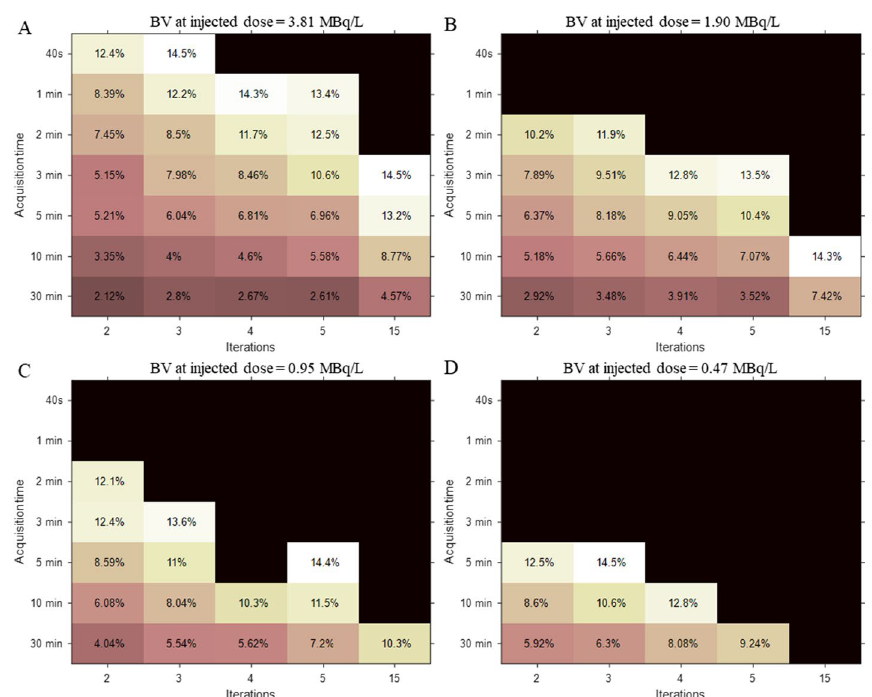
Fig. 2 Background variability (BV) map, which is derived from NEMA IQ phantom measurement (hot sphere: background, 4:1) at four estimated doses, as a function of both factors—acquisition time and iterations. The dark area represents that BV value is more than